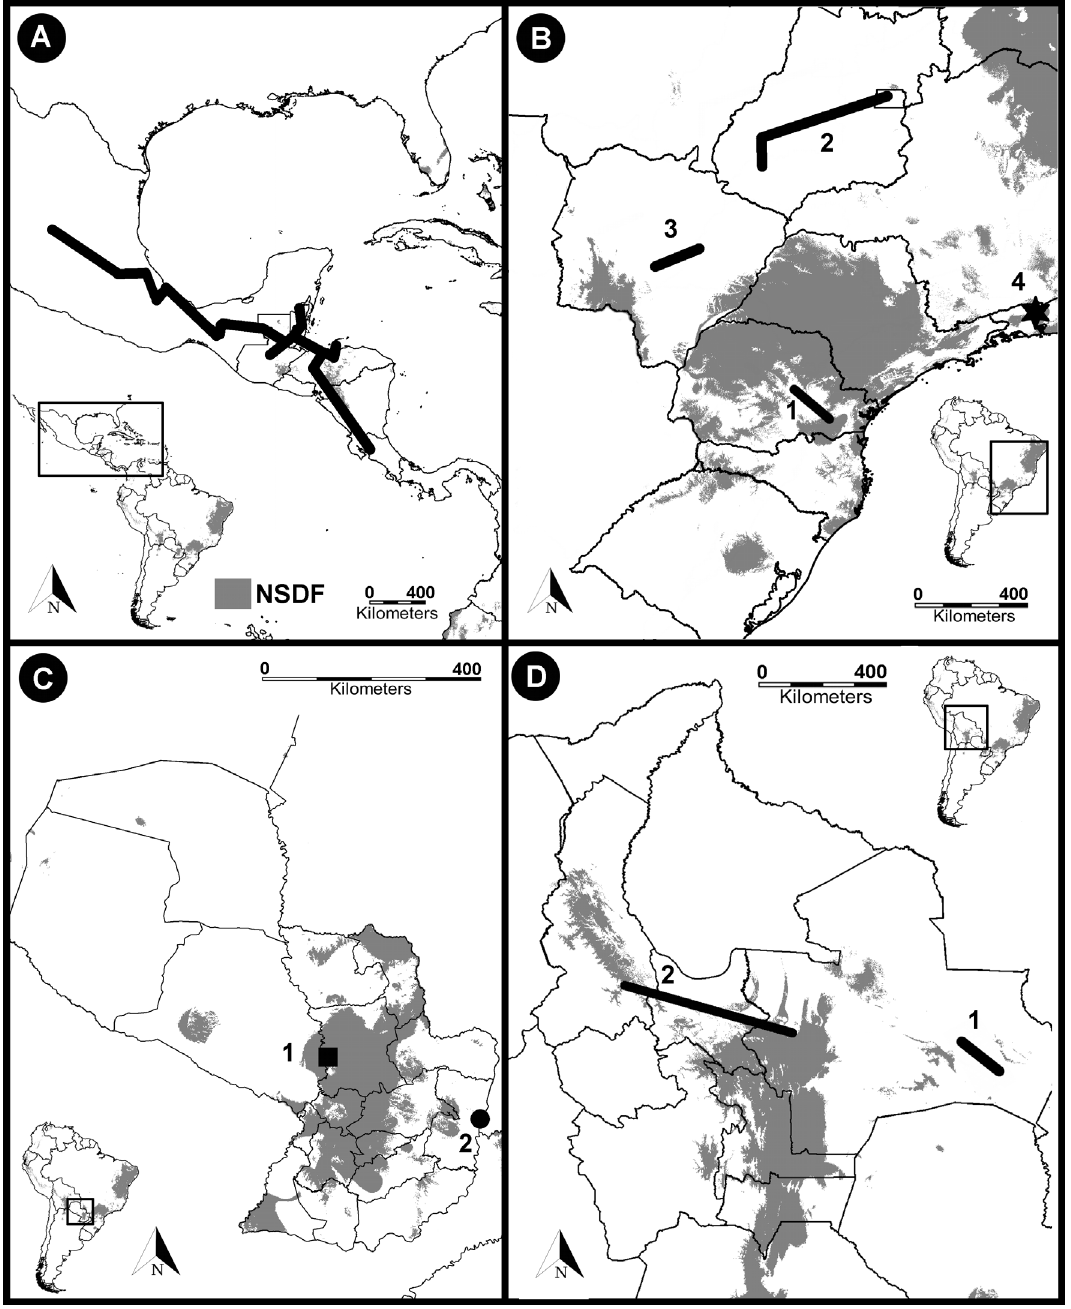
Figure 3 – Individual tracks: A, Galianthe angulata ; B, 1: G. elegans , 2: G. macedoi , 3: G. matogrossiana , 4: G. polygonoides ; C, 1: G. hassleriana , 2: G. linearifolia ; D, 1: G. chiquitosiana , 2: G. sudyungensis